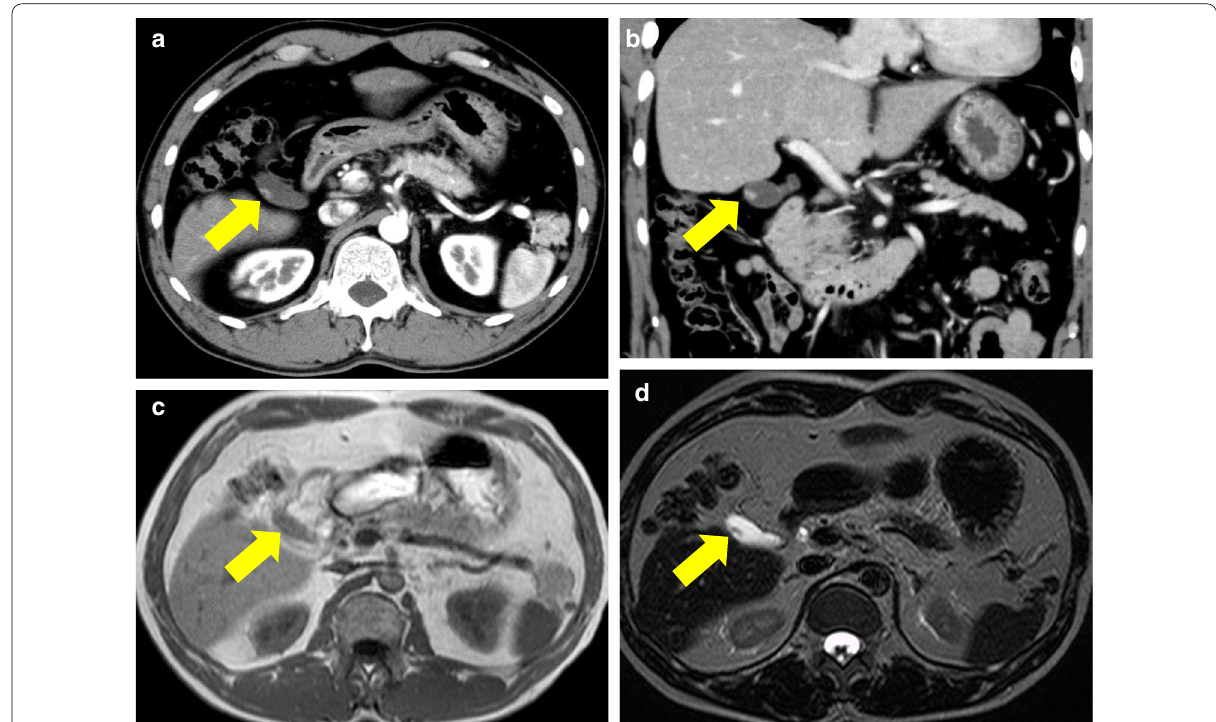
Fig. 2 Contrast‑enhanced computed tomography of the abdomen showed an enhanced polyp in the a axial and b coronal sections. c Axial